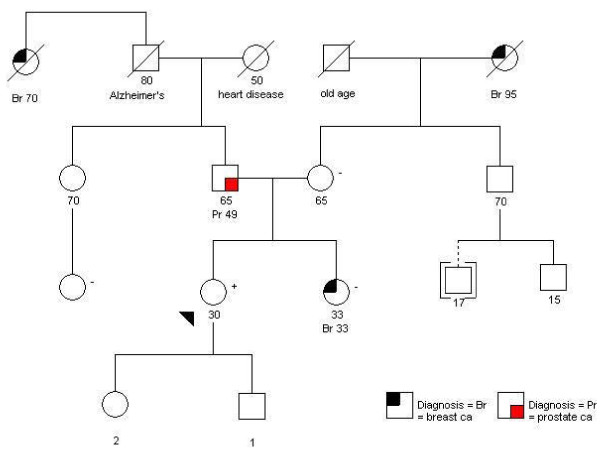
Patient Pedigree.